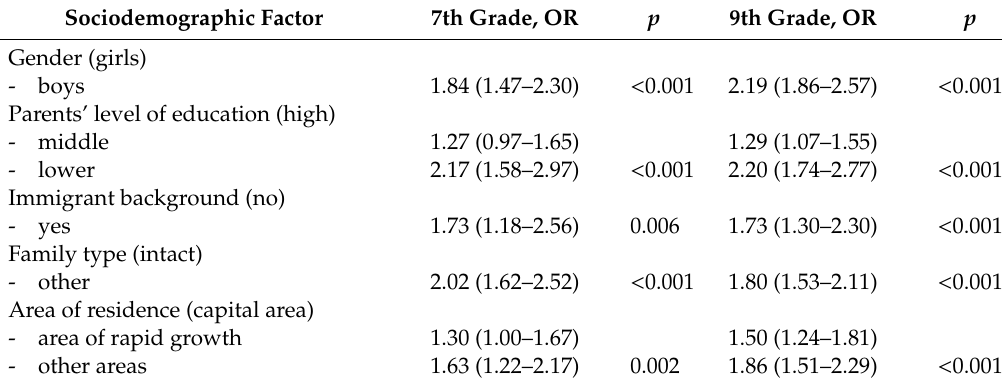
Table 4. Sociodemographic factors accounting for accumulated disadvantage at the 7th and at the 9th grades. Odds ratios (OR, 95% CI: Confidence Interval) and p -values, bivariate models.